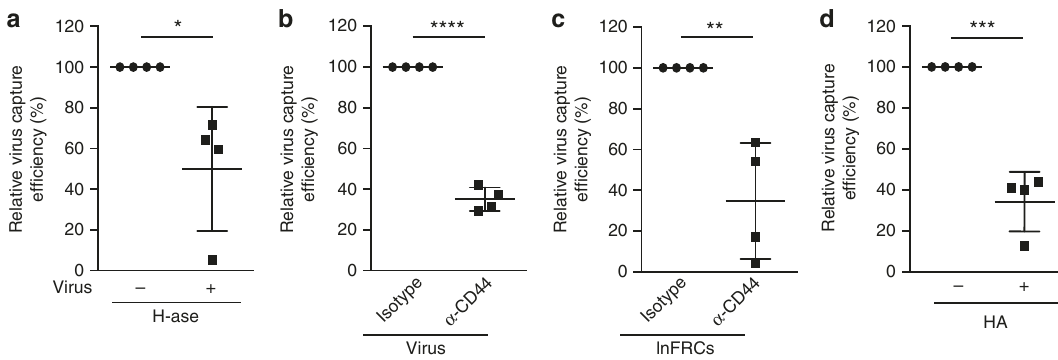
Fig. 8 HLAC-derived virus is captured by lnFRCs in a HA- and CD44-dependent manner. The effects of the following treatments on virus capture by lnFRCs were examined using 25.4 ng p24 of HLAC-derived virus as inoculums. The amount of captured virus was quanti fi ed by p24 ELISA assays. n = 4 different HLAC donors. a HLAC-derived virus was either untreated or pretreated with 10 units/ml hyaluronidase (H-ase) for 1 h. lnFRCs were incubated with the virus for 2 h without separating virus from H-ase. b HLAC-derived virus was either untreated or pretreated with 0.625 μ g/ml anti-CD44 for 1 h. lnFRCs were incubated with the virus for 2 h without separating virus from anti-CD44. c lnFRCs were either untreated or pre-incubated with 10 μ g/ml anti-CD44 antibody for 1 h, and excess antibodies were removed by washing cells with PBS twice. The cells were then incubated with HLAC-derived virus for 2 h. d lnFRCs were incubated with HLAC-derived virus in the absence or presence of exogenous <10 kDa HA (2.5 mg/ml) for 2 h. lnFRCs from one donor were used for these experiments. Data represent the mean ± SD. The p -values were determined using two-tailed Student ’ s t -test. * p < 0.05; ** p < 0.01;*** p < 0.001; **** p <